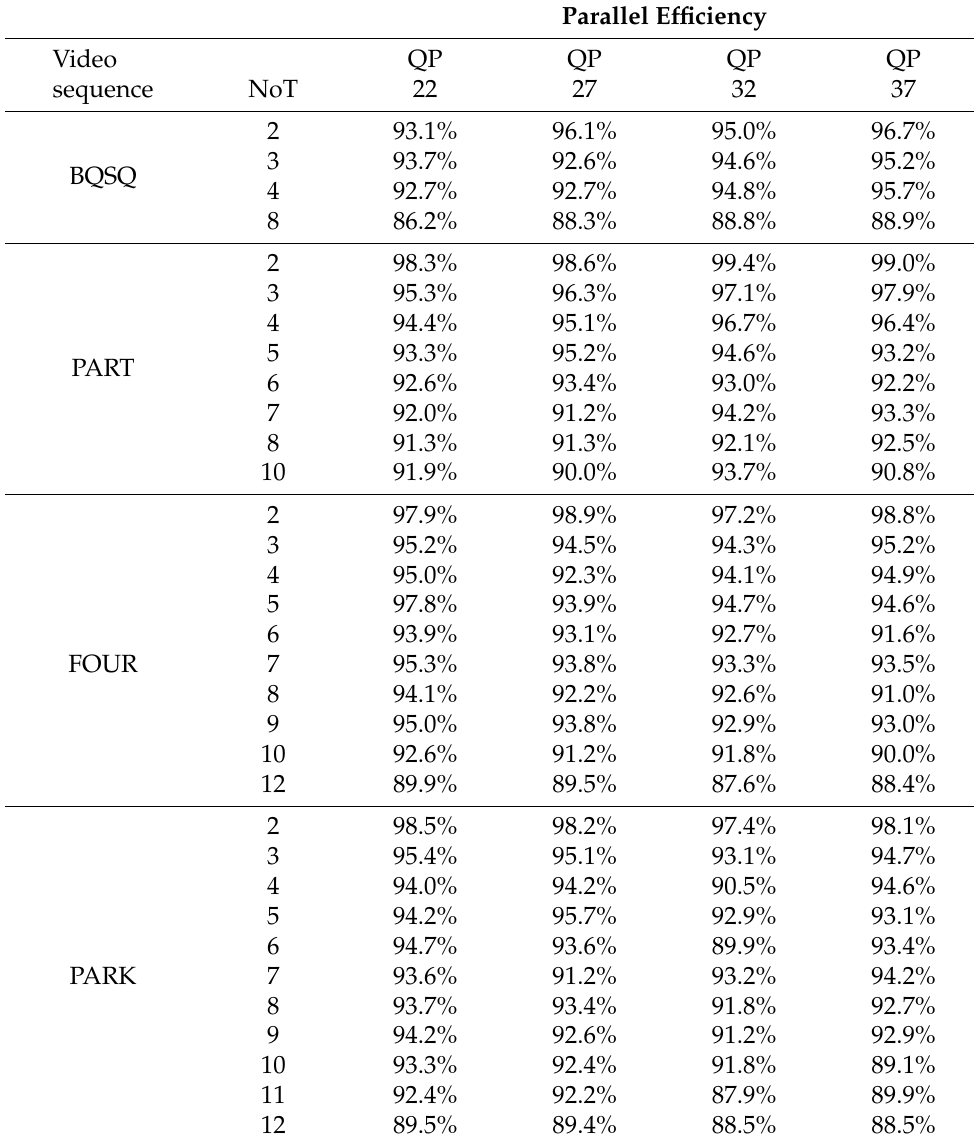
Table 14. Parallel efficiency for Algorithm